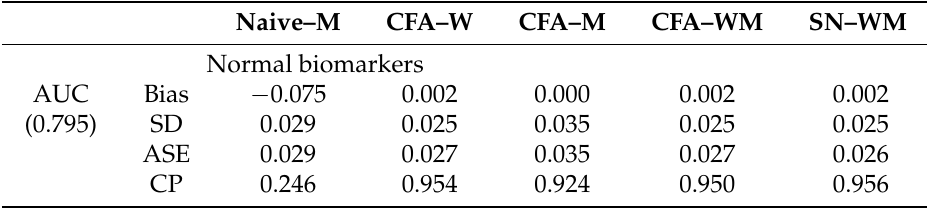
Table 2. Simulation study when σ u = 0.2 (clinical assay), σ v = 1 (research